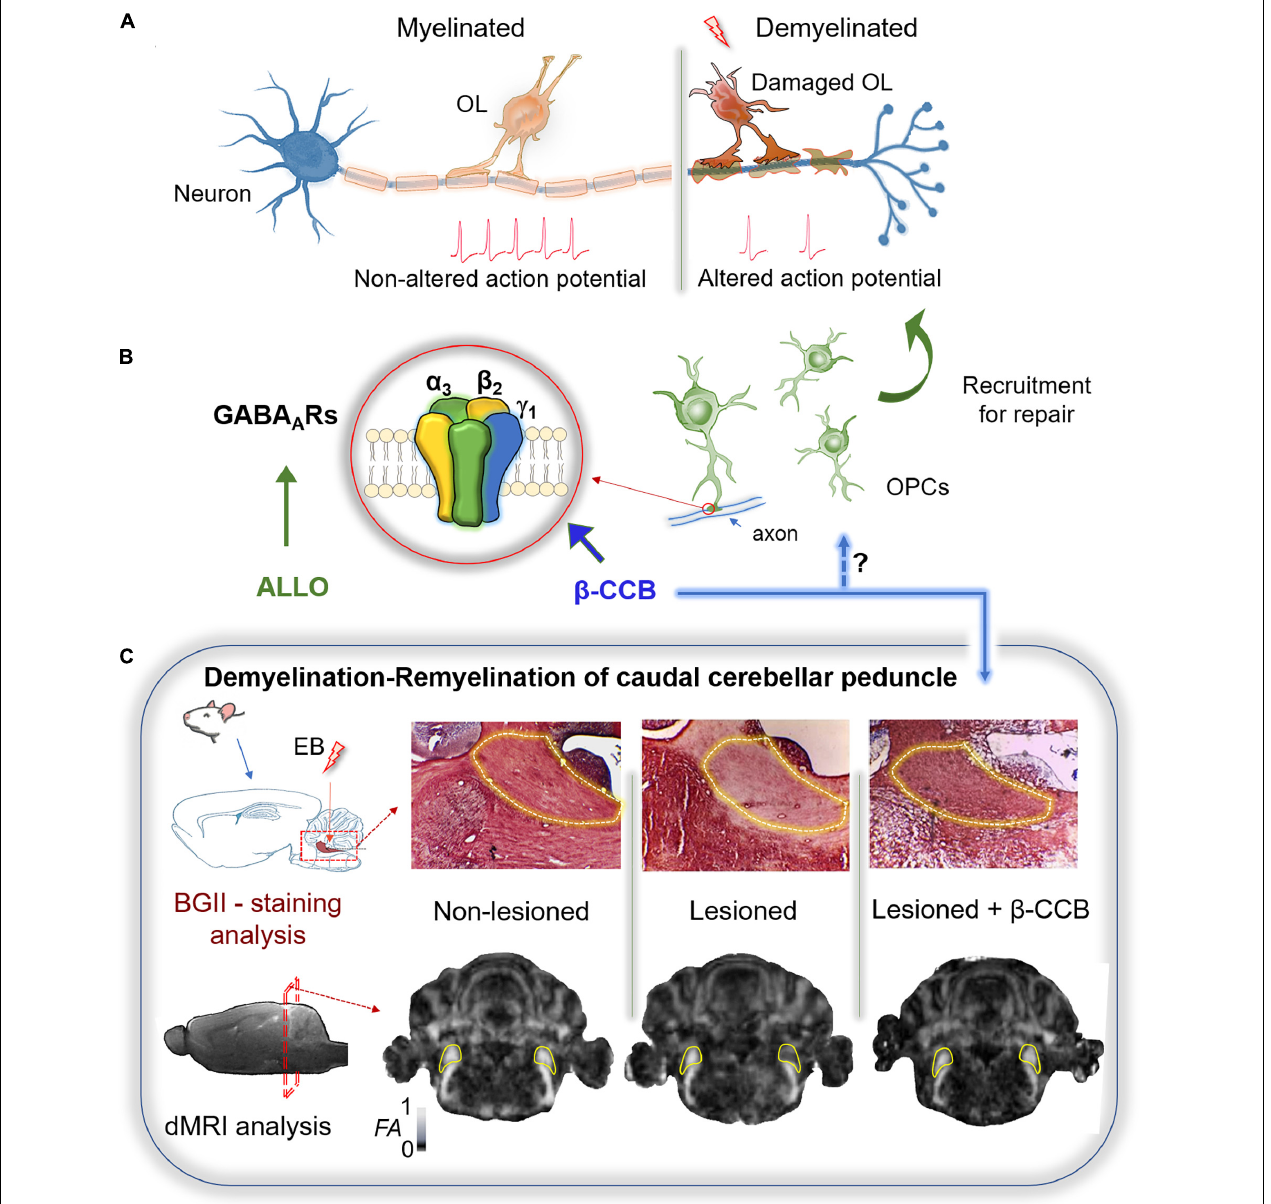
FIGURE 1 | Therapeutic potential of GABAergic signaling on remyelination. (A) Myelin sheath accelerates the action potential propagation. The loss of oligodendrocytes (OLs) after white matter injury results in demyelination and altered conduction of the nerve impulse. (B) Remyelination requires of OPCs recruitment. These cells express mainly a GABA A R with a defined subunit arrangement ( α 3, β 2, γ 1) that is potentiated by some β -carbolines (particularly β -CCB). Allopregnanolone (ALLO) also modulates positively several GABA A Rs and has been shown to promote myelination in different models of demyelination. (C) Demyelination of the rat caudal cerebellar peduncle (c.c.p.; yellow line area in both tissue and MRI sections) was used as an experimental model to test the effect of β -carbolines on remyelination. Stereological injection of ethidium bromide (EB) in the c.c.p. induced its demyelination. Both black gold II (BGII) staining,